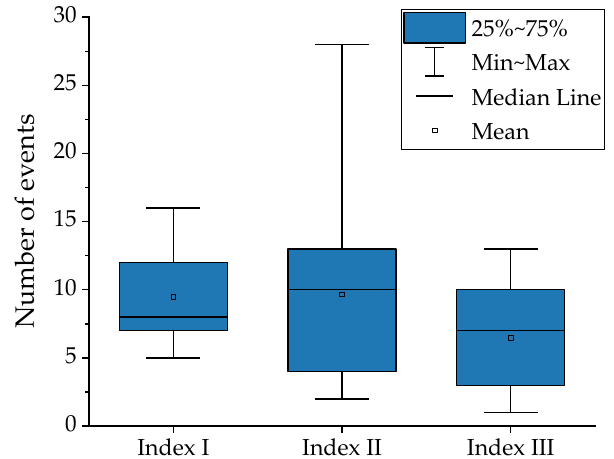
Figure 8. Number of cases with individual weather indices achieved in the years 1970–2019. Index I, daily precipitation index; Index II, frost day index; Index III, hot day index.